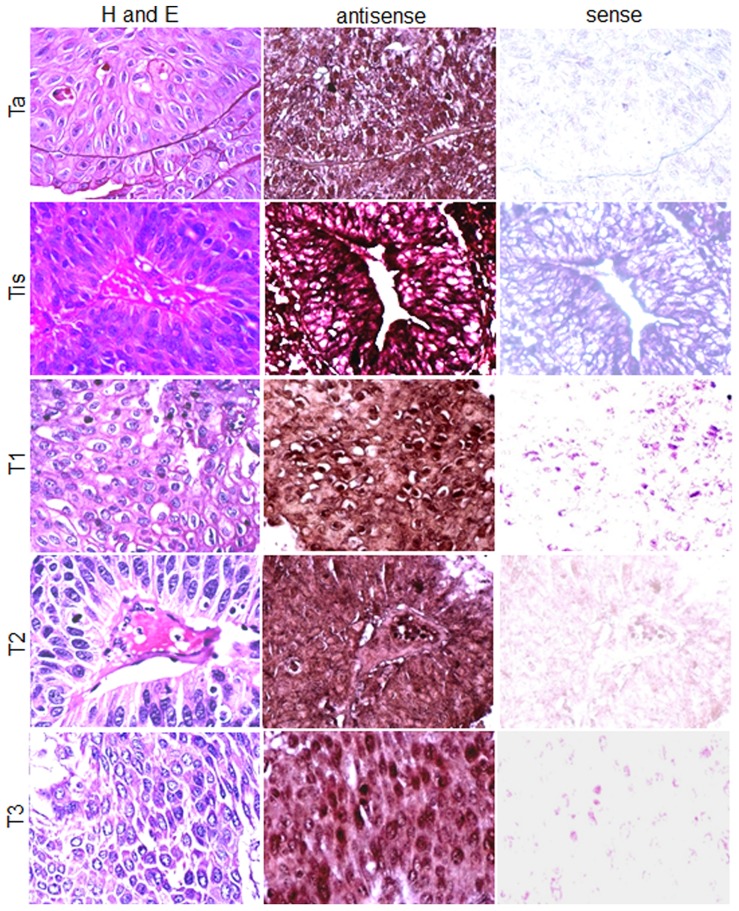
Cell type SPAG9 gene expression in bladder TCC patient’s tissues.Representative H&E stained tissue specimens showing cytostructure of Ta, Tis, T1, T2 and T3 stages (left panel). In situ RNA hybridization showing SPAG9 expression in matched serial tissue section from same specimens of Ta, Tis, T1, T2 and T3 stages showed a strong chocolate brown color with digoxigenin-labeled SPAG9 antisense riboprobes (middle panel). However, SPAG9 sense riboprobe failed to show the signal (right panel). Original magnification, ×400; objective, 40×.